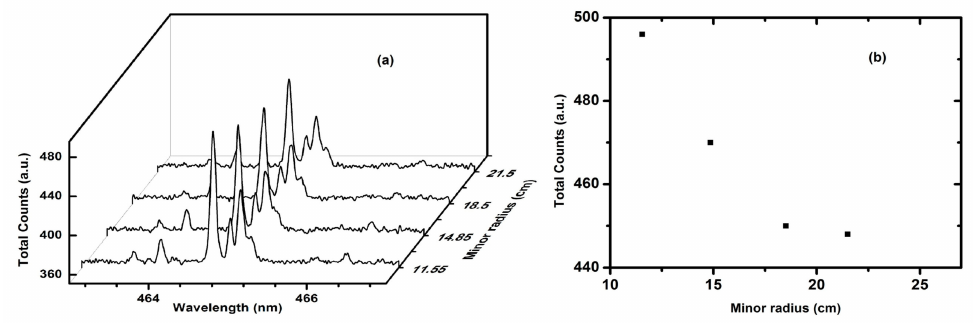
Figure 5. ( a ) Space resolved spectra of C 2 + for four tracks corresponding to four lines of sight and ( b ) total counts along each line of sight with respect to plasma minor